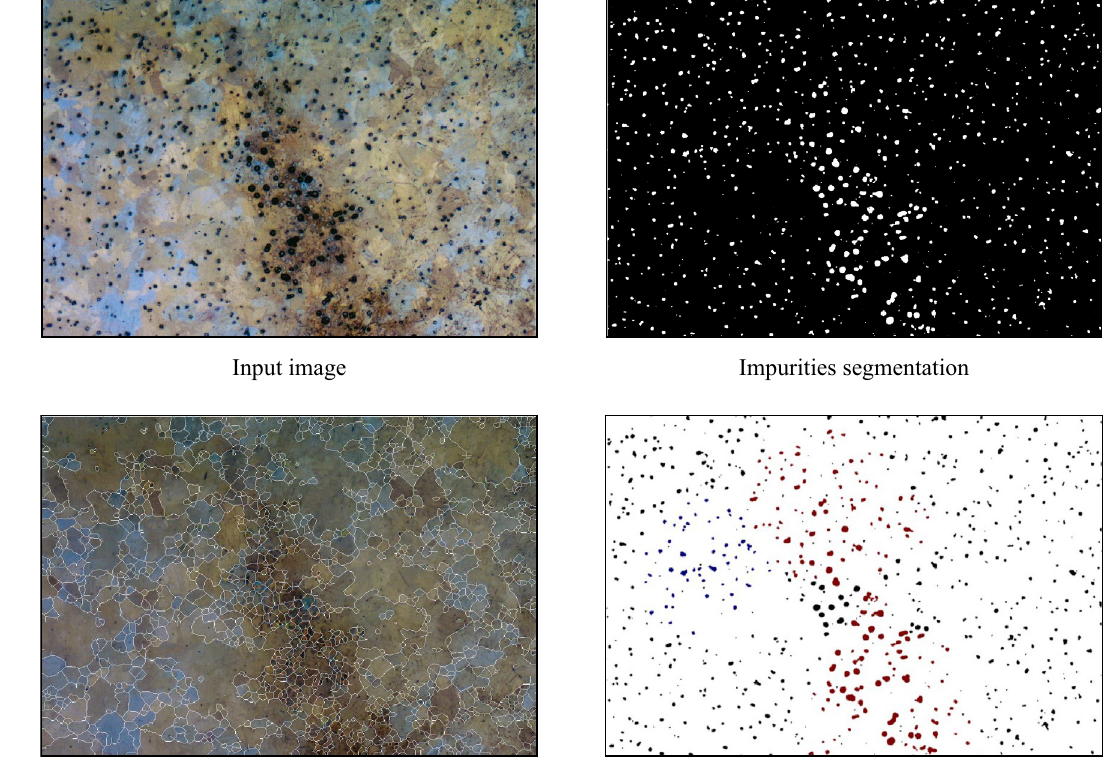
Figure 25. Example